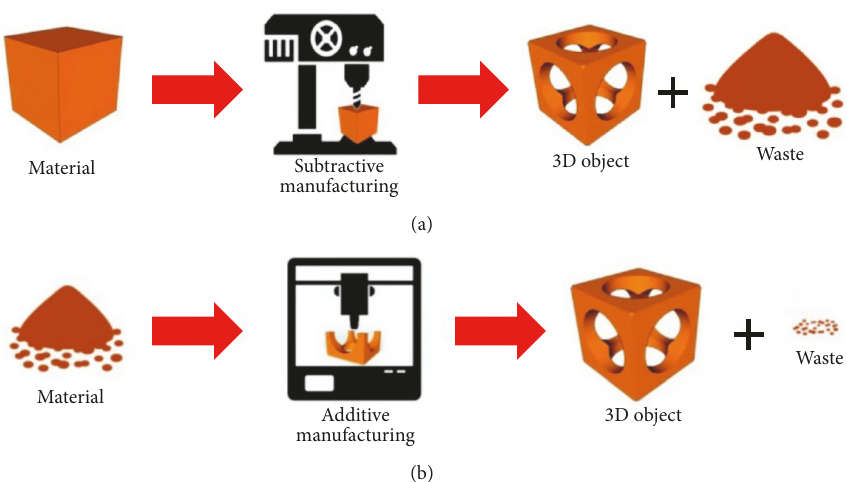
Figure 1: (a) Subtractive manufacturing versus (b) additive manufacturing (source: reproduced and adapted with permission from Ambrosi et al.).